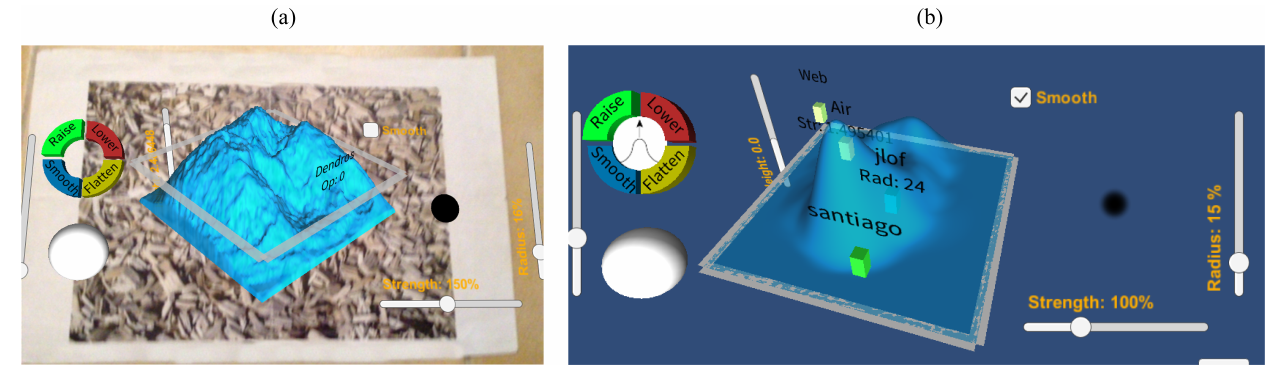
Figure 5. Snapshots of ( a ) the AR-based and ( b ) standard interaction modes.